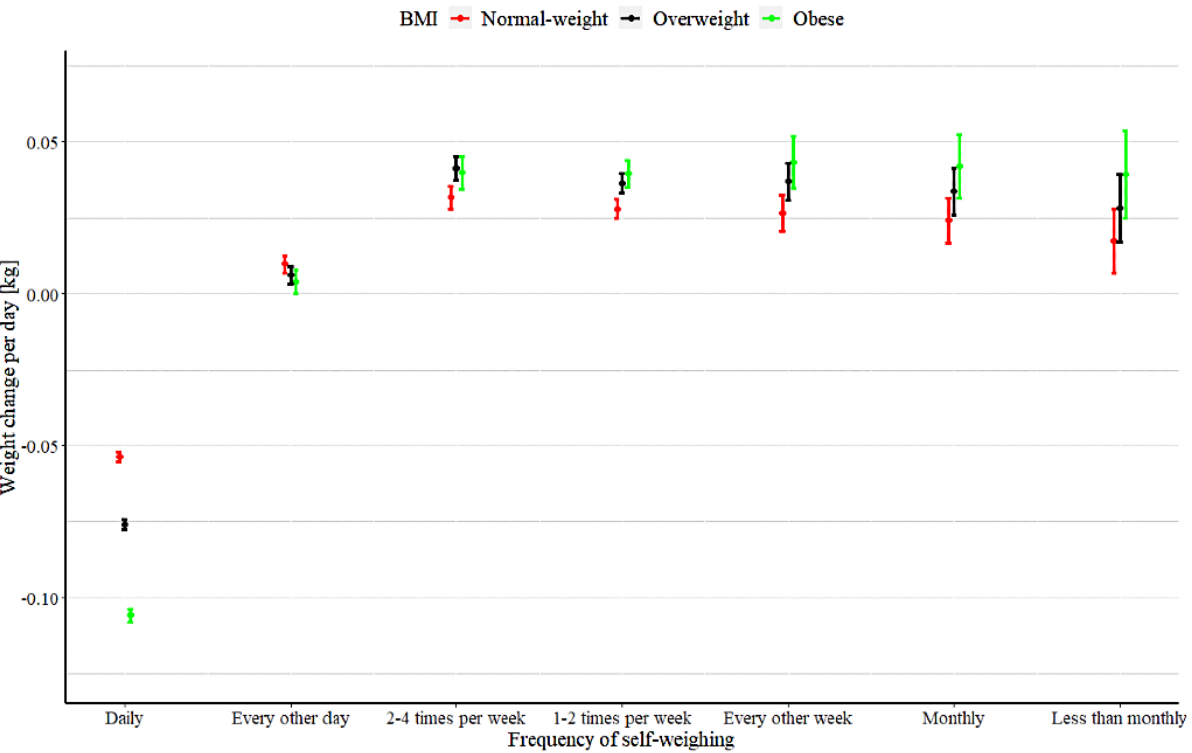
Figure 3. Weight change per day predicted by the interaction between the frequency of self-weighing and BMI group.